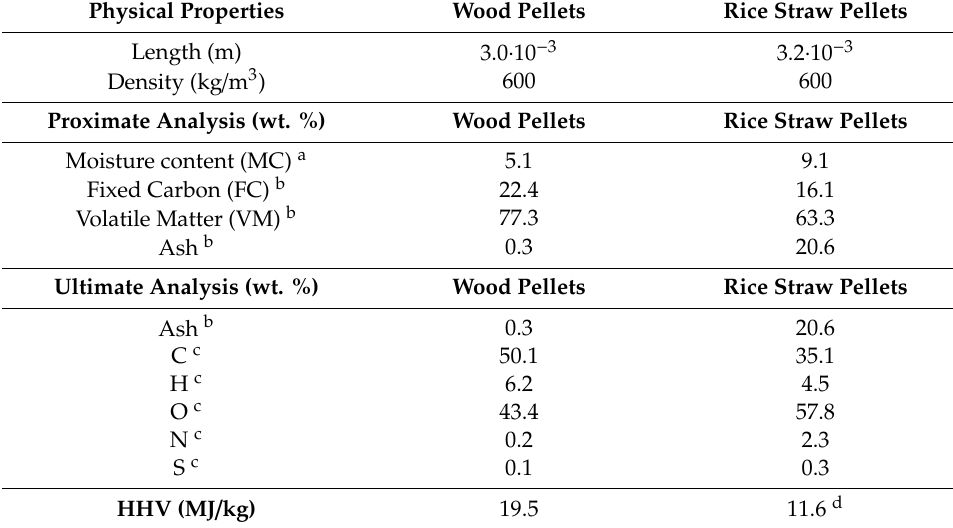
Table 1. Physical and physico-chemical properties of wood and rice straw pellets